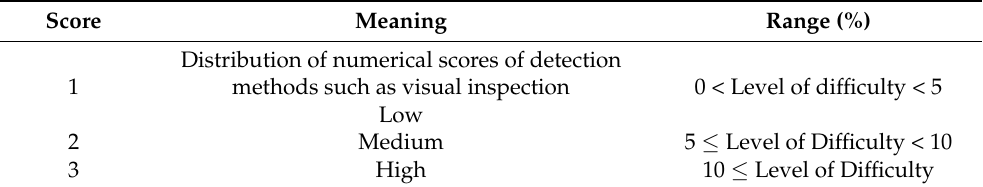
Table 7. Detection score estimation criteria.